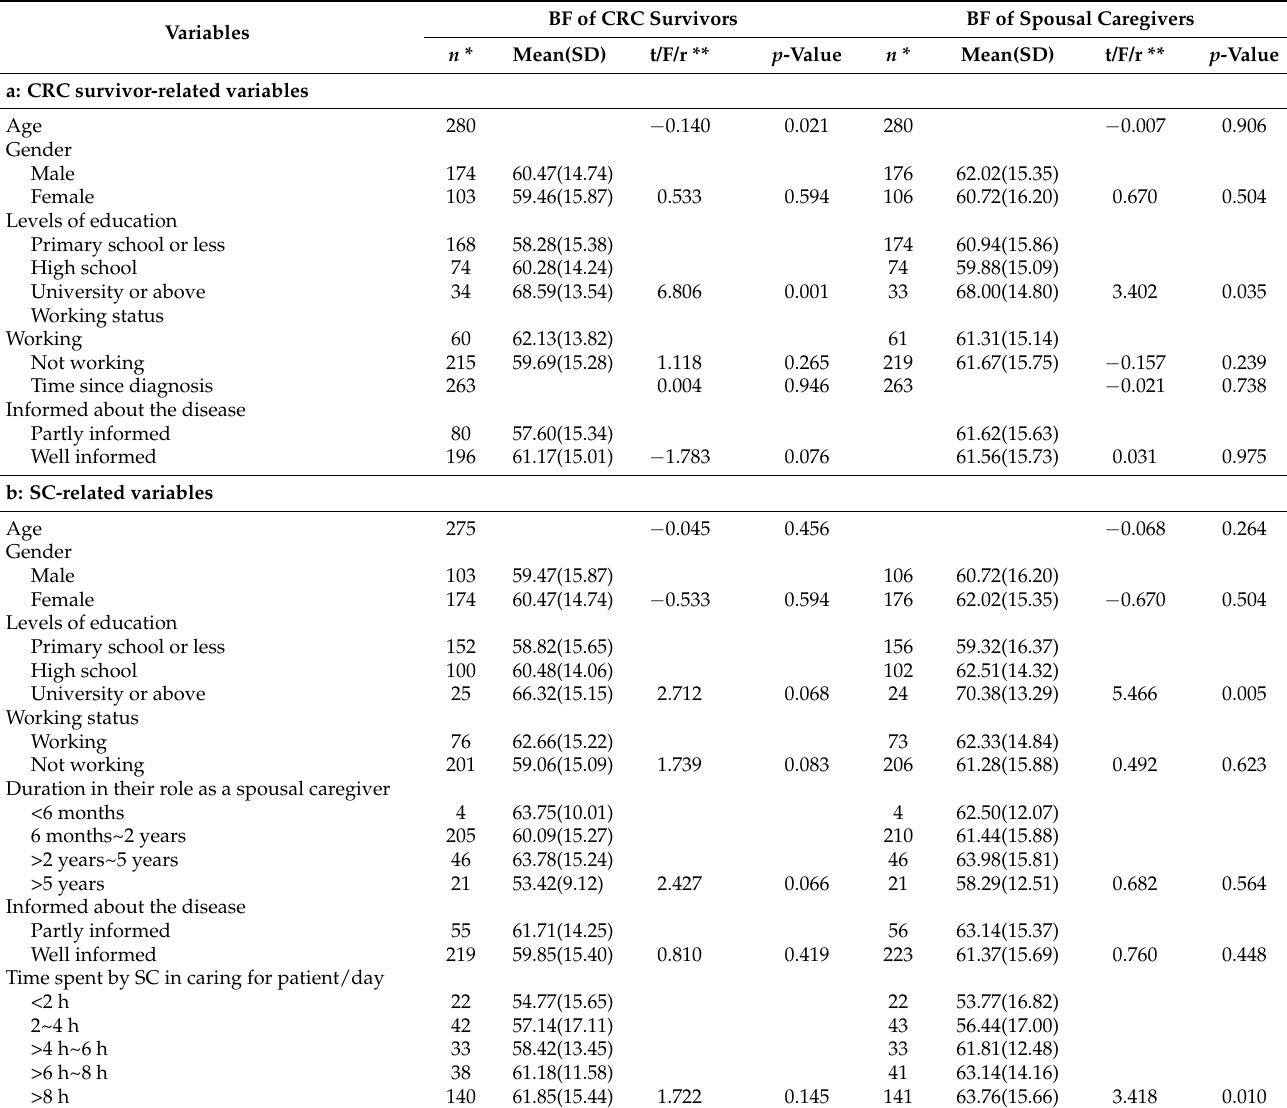
Table 5. Correlations of overall Benefit Finding Scale level with sociodemographic variables in colorectal cancer survivors and spousal caregivers ( n = 286).